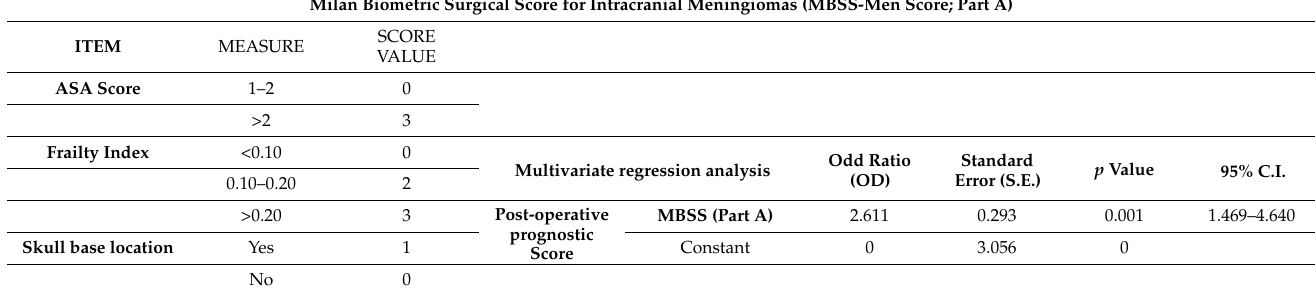
Table 4. MBSS Part A and Part B scores: classification performance and sub-group